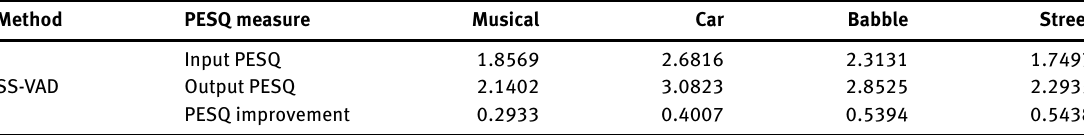
Table 2: Performance Measurement of SS-VAD Method in Terms of PESQ for TIMIT Database.